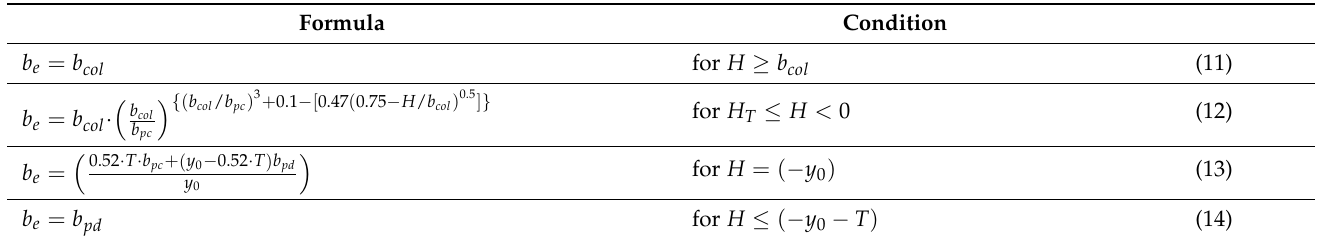
Table 3. Equivalent pier diameter formulae based on influence of the pile cap elevation.